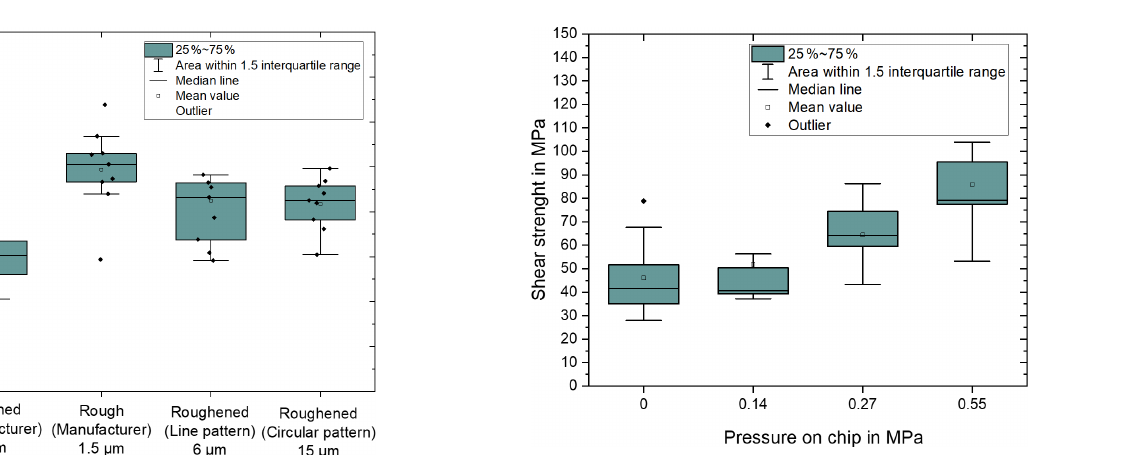
Figure 15. Shear strength of glass-soldered Al 2 O 3 chips on dif- ferently structured sapphire substrates. Glass solder G018-385 and sample size n = 9.